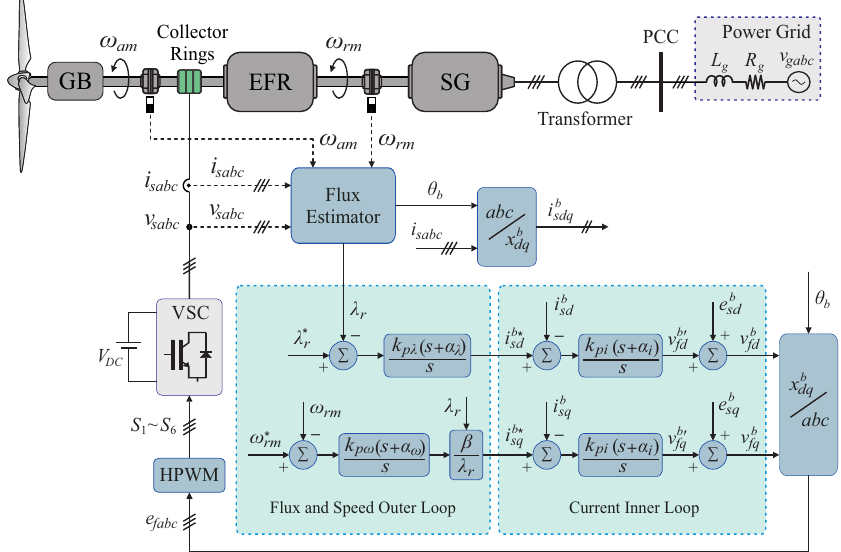
Figure 2. Topology of the wind system with EFR and its control